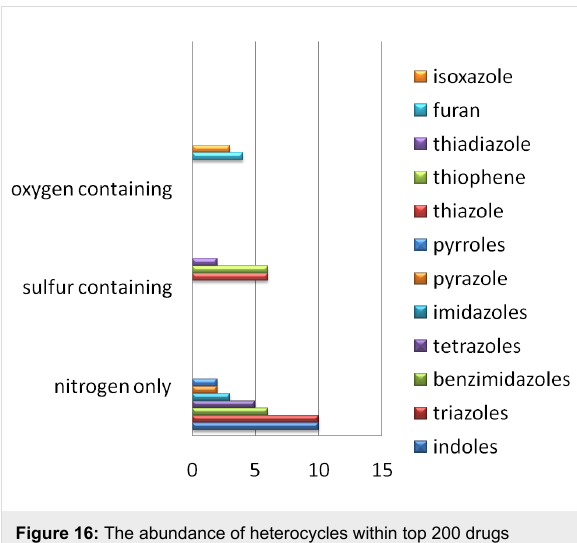
Figure 16: The abundance of heterocycles within top 200 drugs (5-membered rings).